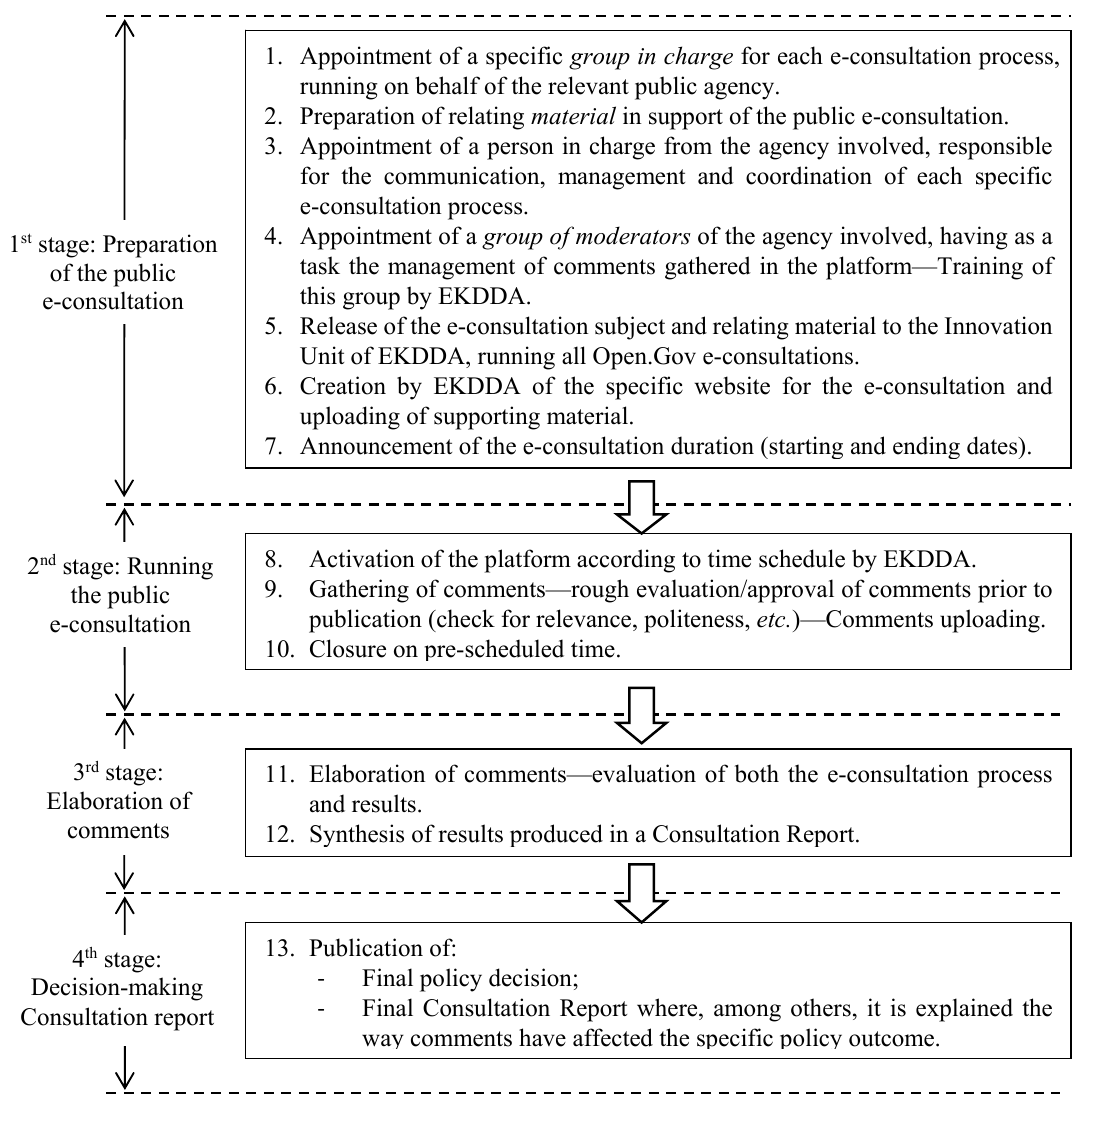
Figure 3. Successive stages of public e-consultation process in the “OpenGov”